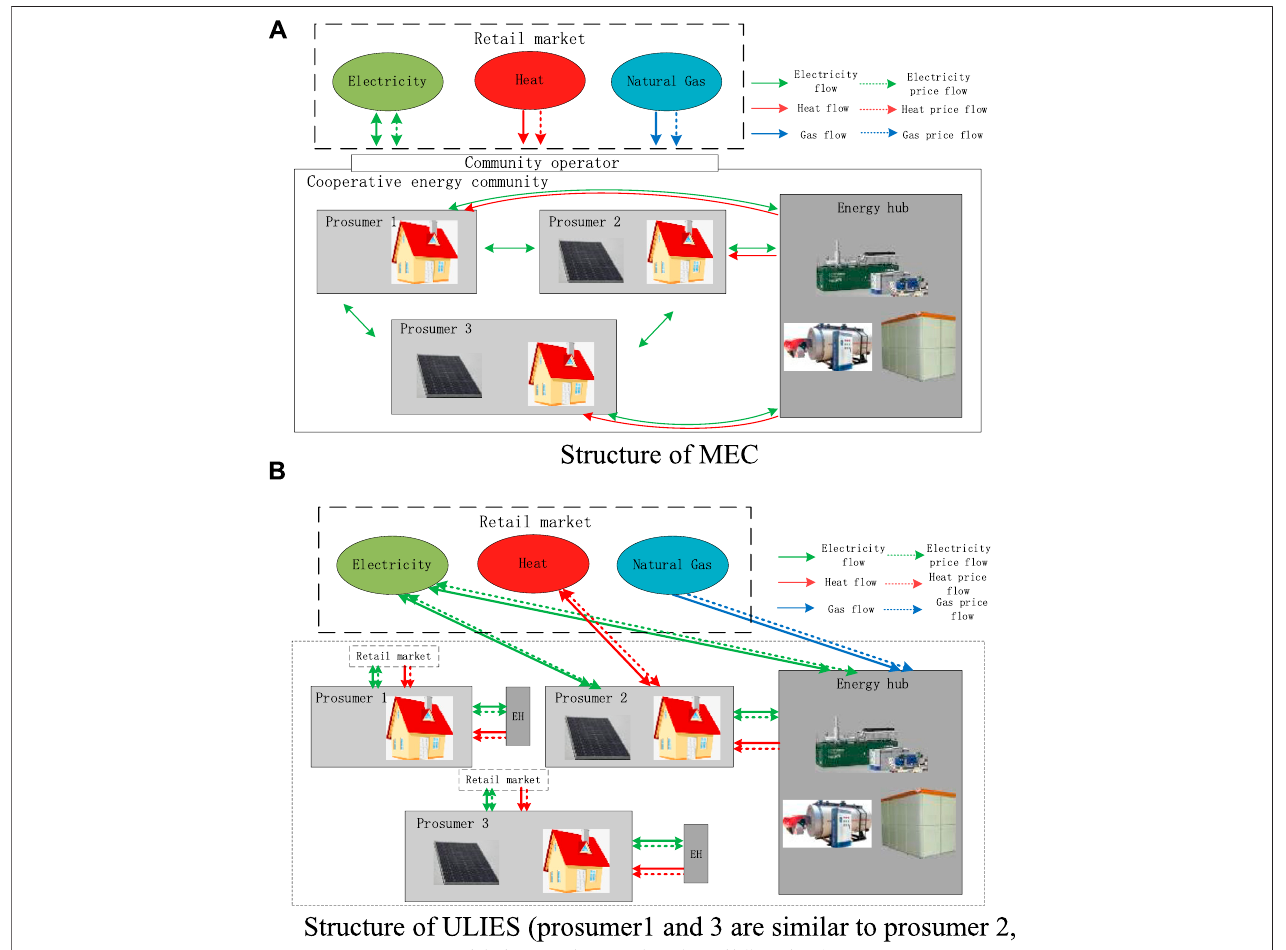
FIGURE 1 | Trading mechanism structure. (A) Structure of MEC. (B) Structure of ULIES (prosumers 1 and 3 are similar to prosumer 2, which are drawn in simpli fi cation). MEC, multi-energy community; ULIES, local integrated energy system